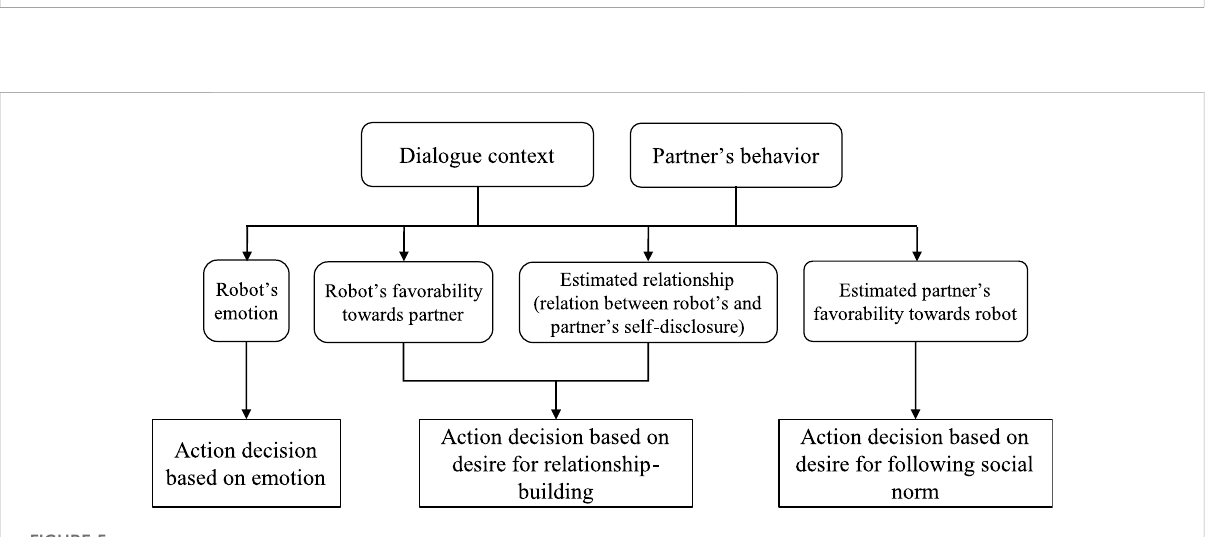
FIGURE 5 Relationship between the internal states and desires of the